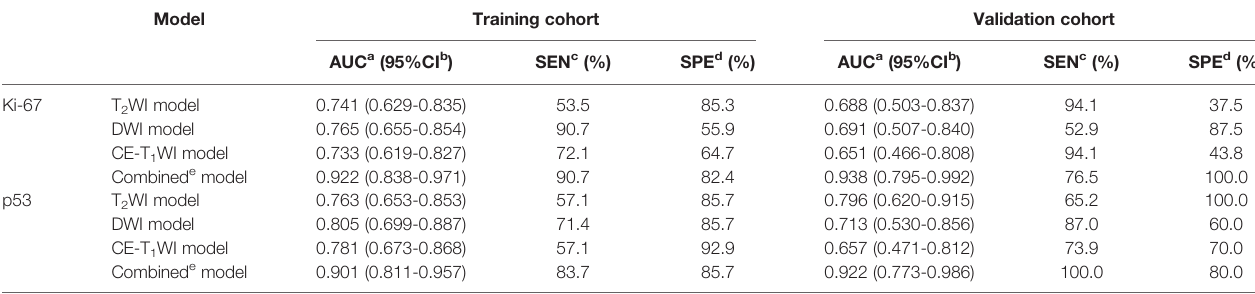
TABLE 5 | The predictive performance of the models in training and validation cohort. Model